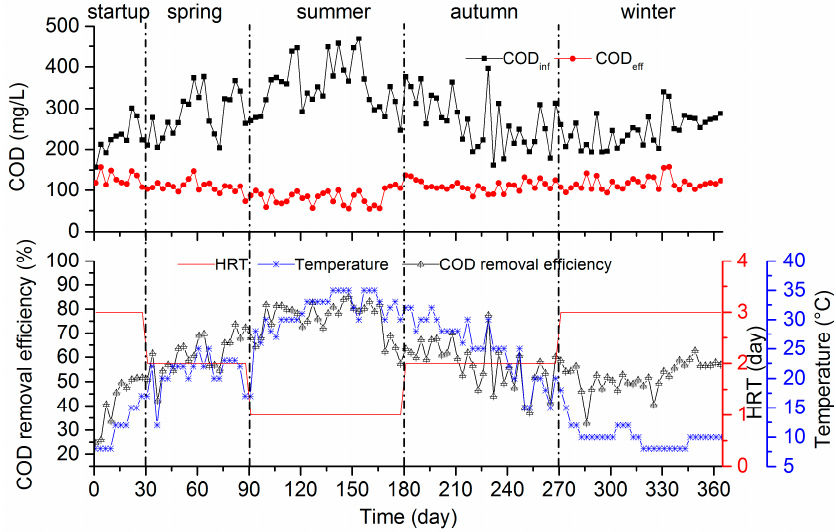
Figure 2. Influent and effluent concentrations of chemical oxygen demand (COD) and COD removal efficiency.